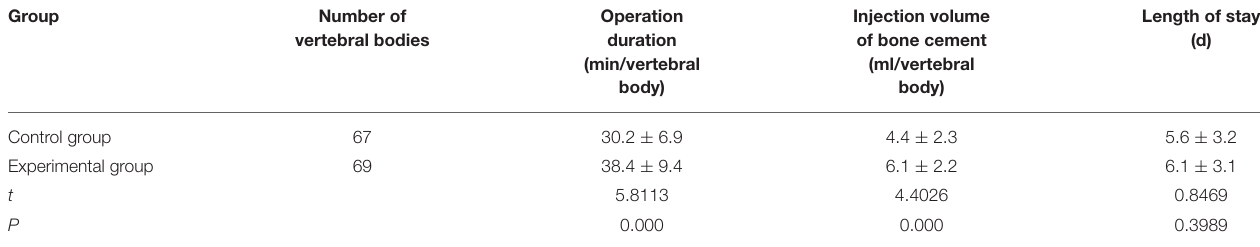
TABLE 2 | Comparison of intraoperative indexes ( x ± s).